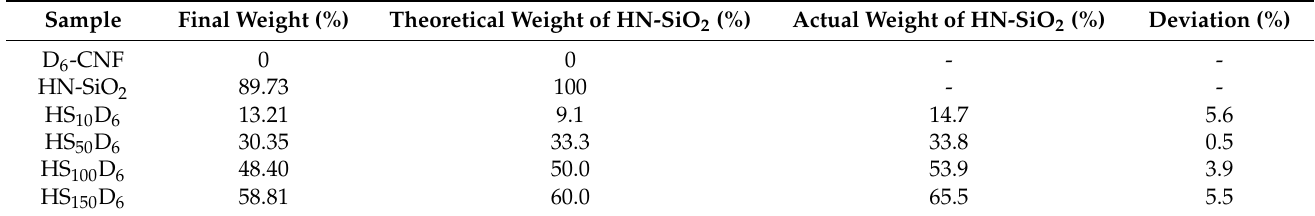
Table 1. Determination weight percent of HN-SiO 2 in HS n D 6 by TGA.